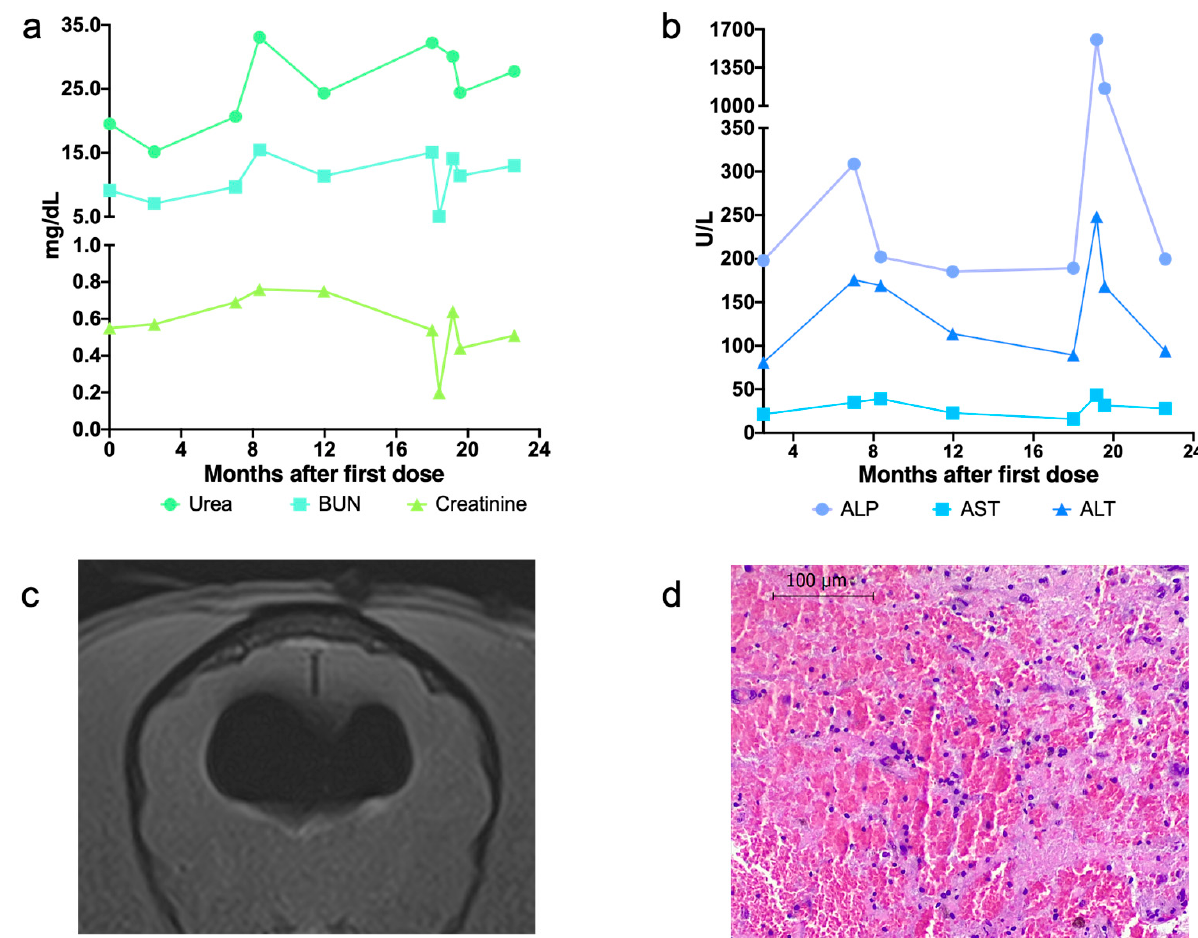
Figure 2. ( a , b ) Peripheral blood parameters during follow-up. Quantification of renal biomarkers ( a ) and hepatic enzymes ( b ) in peripheral blood. ( c ) Pneumocephalus image by MRI. Image from 15 days after the second craniotomy. ( d ) Tumor tissue at necropsy. Image of hematoxylin-eosin stained tissue. Scale bar: 100 μ m. BUN, blood urea nitrogen; ALP, alkaline phosphatase; AST, aspartate ami- notransferase; ALT, alanine transaminase.